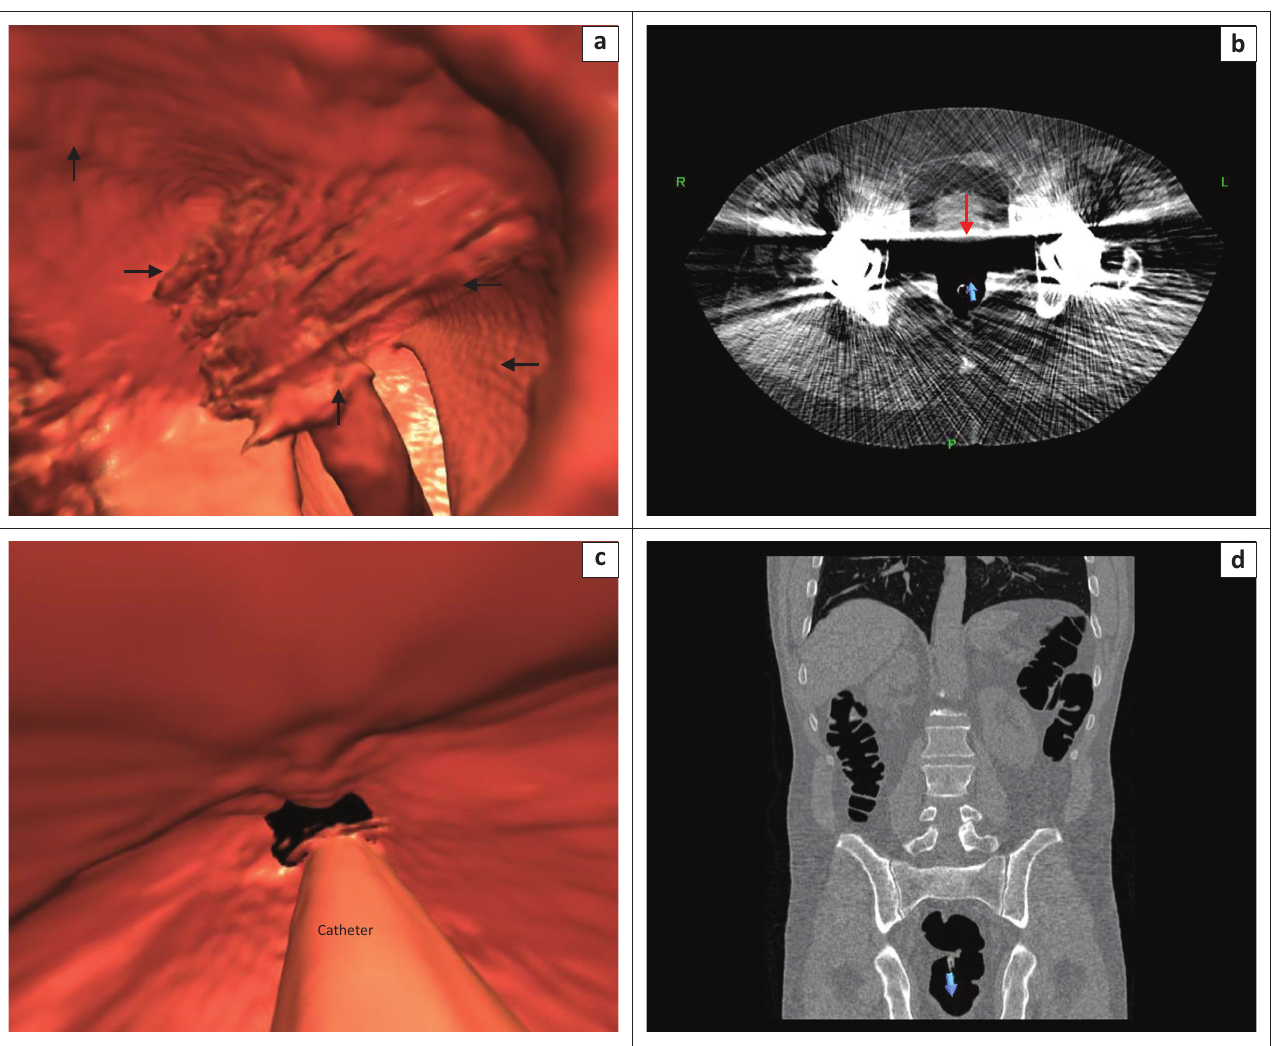
FIGURE 9: (a) 3D endoluminal view showing artefacts (black arrows) obscuring visualisation of the rectum; (b) 2D axial of the same patient shows streak artefacts limiting visualisation of colon (red arrow). This is a typical example of artefacts caused by hip prostheses; (c) 3D view shows ‘black hole’ artefact. It represents an absence of data due to poor patient positioning, which caused cut-off related to incomplete scanning; (d) Coronal view shows incorrect positioning of the patient as the symphysis pubis is not included. Correct patient positioning must include 3 cm below symphysis pubis and 3 cm above the diaphragm.